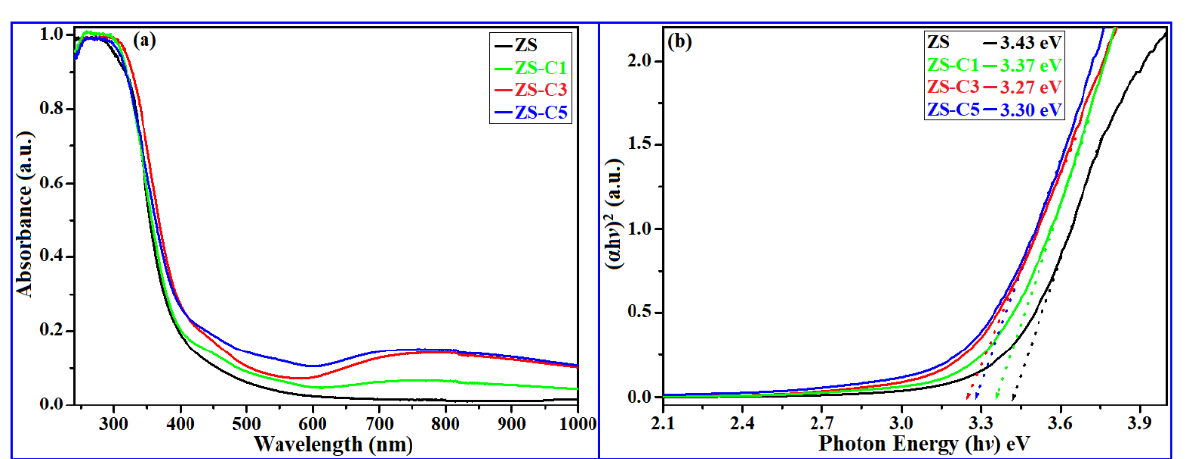
Figure 4. ( a ) Optical absorption and ( b ) Tauc plots of undoped and Cu 2+ -doped ZnO–SnS nanocom- posites.